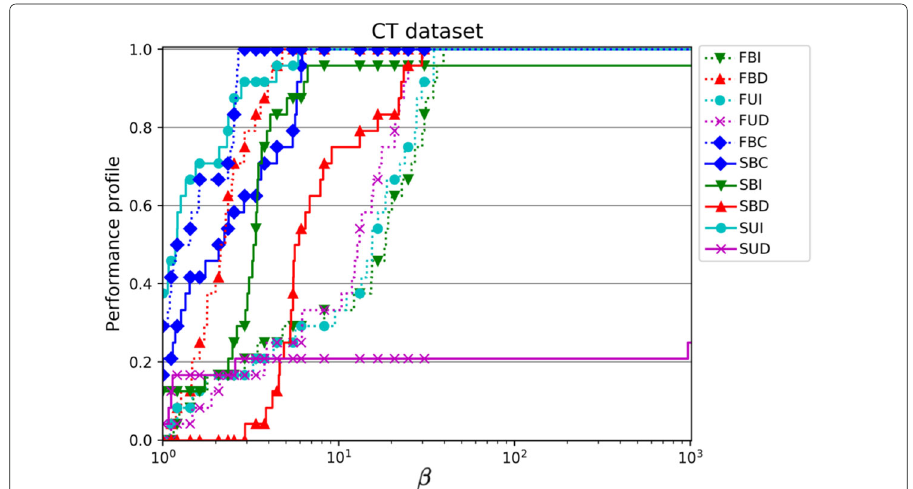
Fig. 15 Performance profile for all 10 methods, for the tests performed on the CT data set